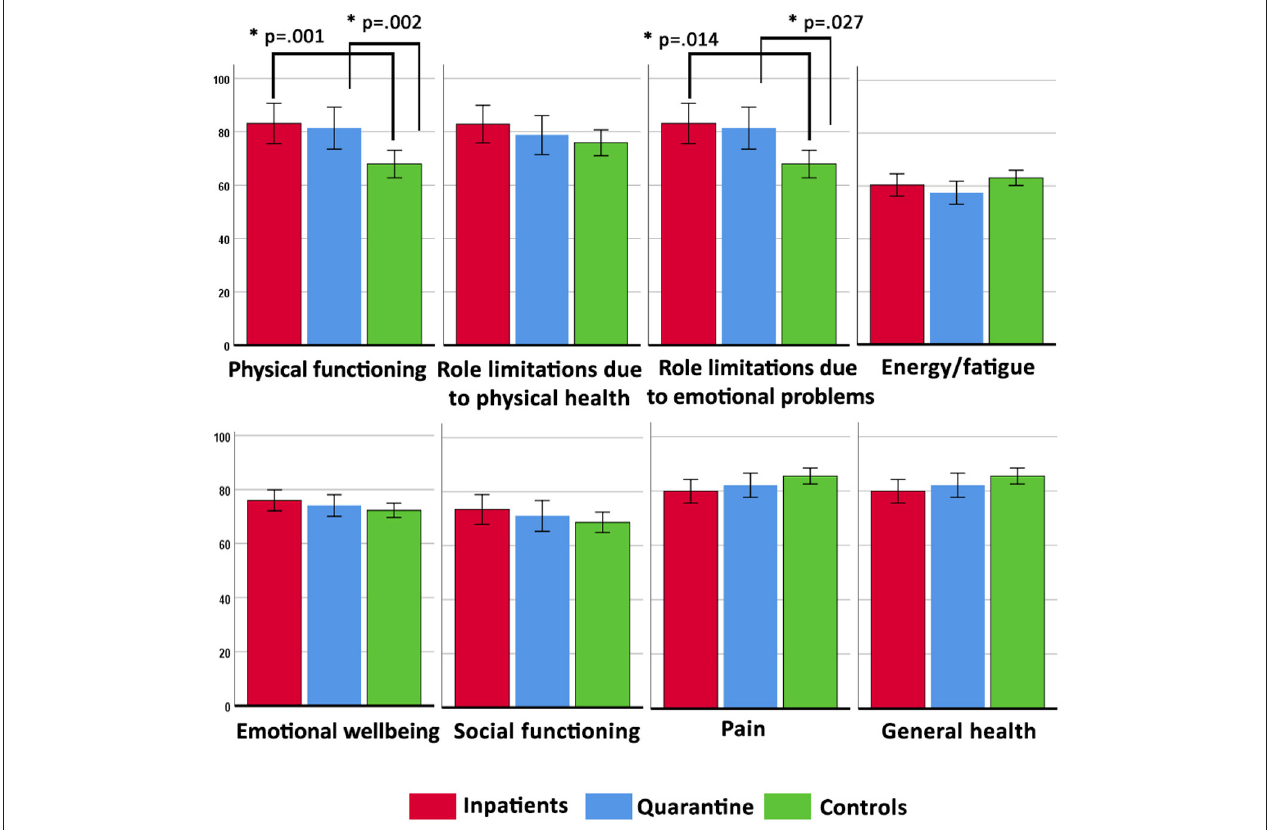
FIGURE 1 | Estimated marginal means (with their 95% error bars) of the SF-36 scores in the inpatient, quarantine, and control groups, controlling for gender, age, past psychiatric history, education, nationality, and occupation. All p values were adjusted for multiple comparisons using the Bonferroni